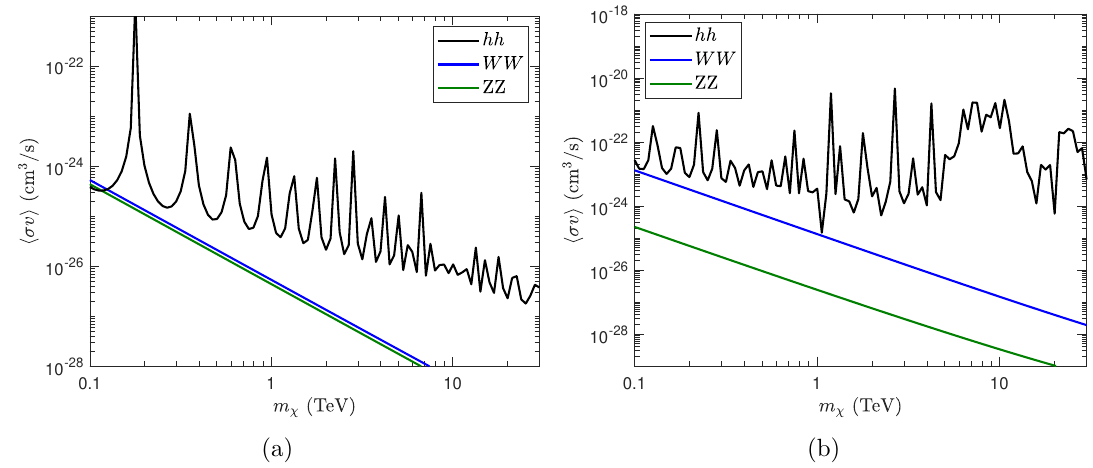
Figure 13. (Left panel) Annihilation cross-section into hh (black), W + W − (blue) and ZZ (green) final products for the complex doublet in the non-degenerate phase when λ 0 / Λ = 0 . 05 GeV − 1 and λ c / Λ = 3 × 10 − 6 GeV − 1 . (Right panel): the same diagram for the pseudo-real quartet at λ 0 / Λ = 0 . 1 GeV − 1 .